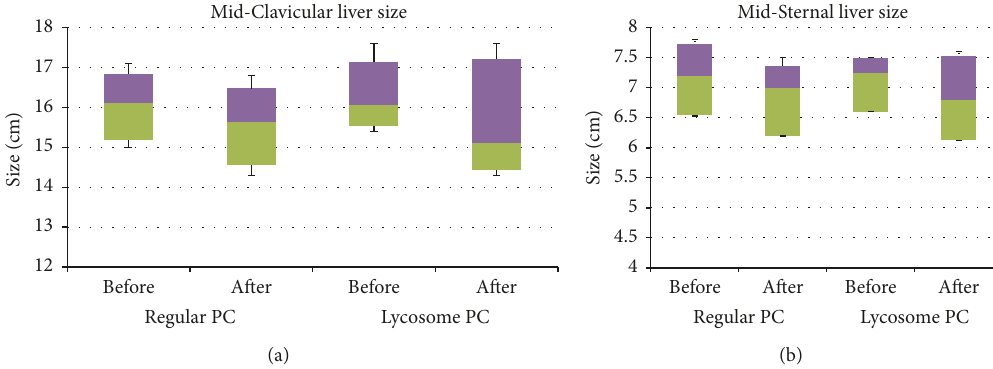
Figure 1: Box-and-whisker analysis of liver span . The patients were screened, enrolled, randomized, and treated with regular (PC) or lycosome (PC-Lycosome) formulations of phosphatidylcholine (PC) for 2 months as described in Materials and Methods. Median values with confidence intervals for Mid-Clavicular (a) and Mid-Sternal (b) liver size at time “0” and the end point of the study are shown above.